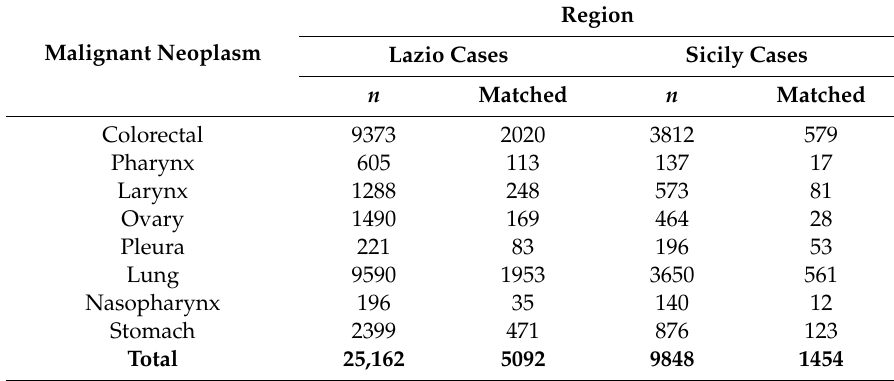
Table 6. Distribution of malignant neoplasm in OCM data (all and matched cases) for Lazio and Sicily.